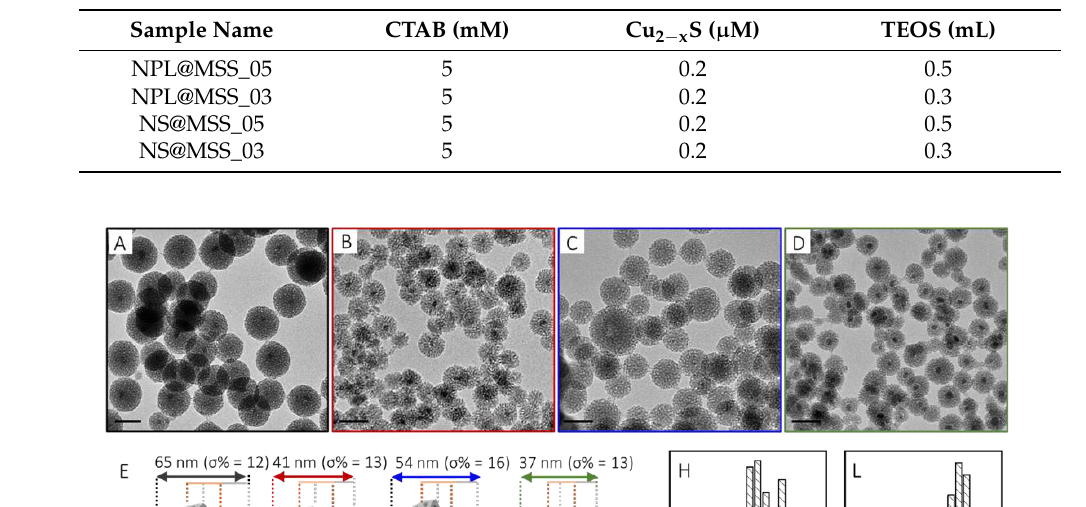
Table 1. Summary of type of samples, concentration of cetyltrimethylammonium bromide (CTAB) and Cu 2 − x S NCs and tetraethylortosilicate (TEOS) volume used for the synthesis of the core-shell NPs using Cu 2 − x S nanospheres (NS) and nanoplates (NPL) as cores.